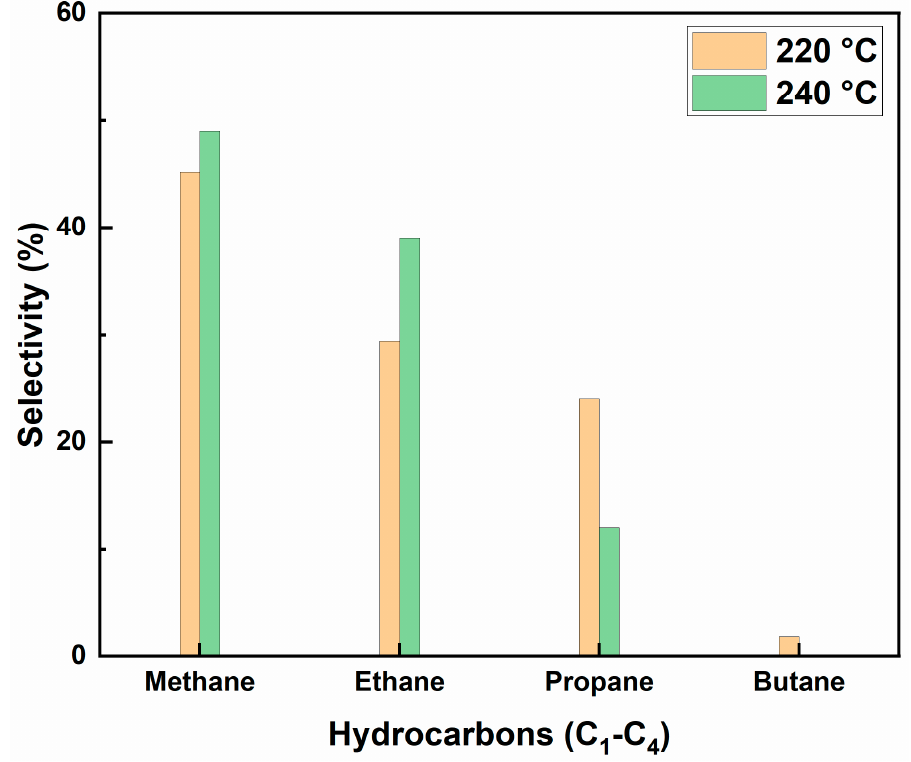
Figure 8. Selectivity of hydrocarbons at 220 °C, with constant H 2 :CO of 2:1